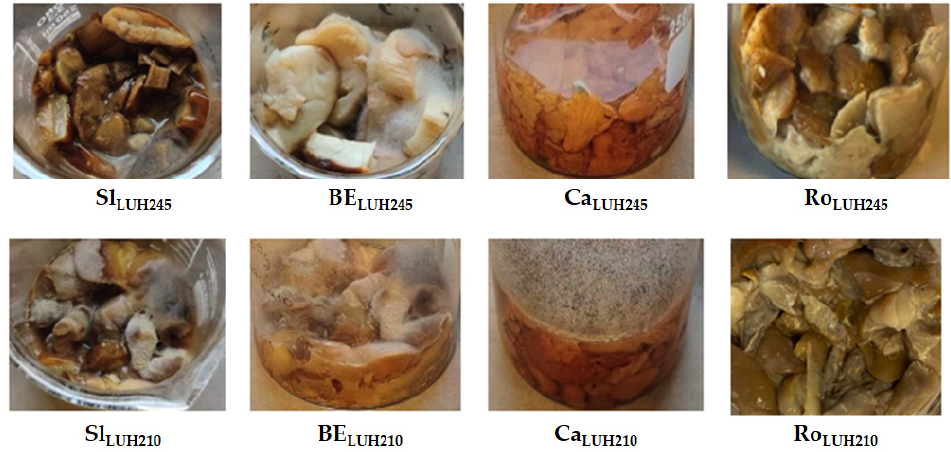
Figure 3. Images of edible mushrooms fermented for 7 days with L. uvarum LUHS245 and L. casei LUHS210 (Sl— Suillus luteus ; BE— Boletus edulis ; Ca— Cantharellus cibarius ; Ro— Rozites caperata ). Images of the pre-treated (boiled and ultrasonicated) mushrooms fermented with L. uvarum LUHS245 are given in Figure 4. After prolonged thermal treatment (30 min) and ultrasonication (30 min), no mould colonies were visible on the surface of the